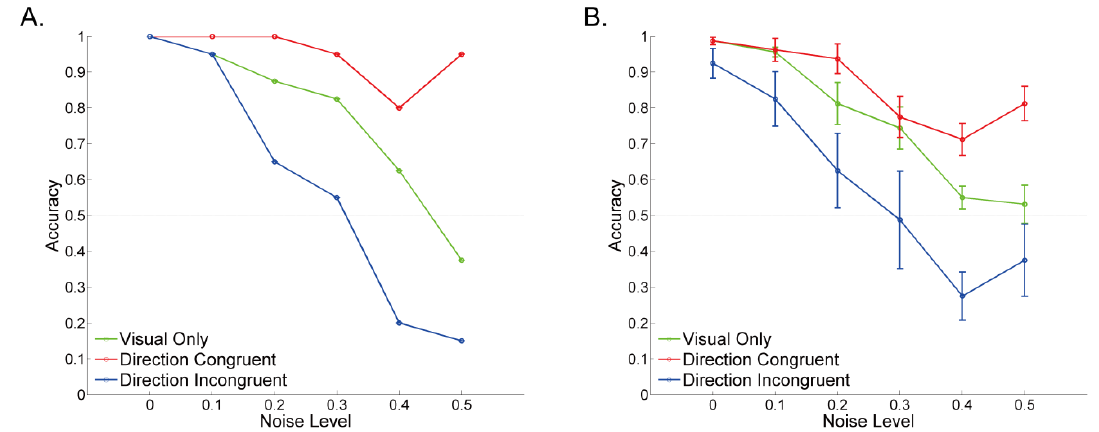
Figure 4. Accuracy in judging the direction of the visual-motion stimulus (left or right) as a function of visual noise level in visual only (green trace), direction congruent (red trace), and direction incongruent (blue trace) conditions. ( A ) Data obtained from a single subject. ( B ) Data averaged across subjects. Error bars indicate the standard error of mean. The results showed that perceived direction of visual motion was biased toward the direction of tactile motion, especially when visual noise level was high.